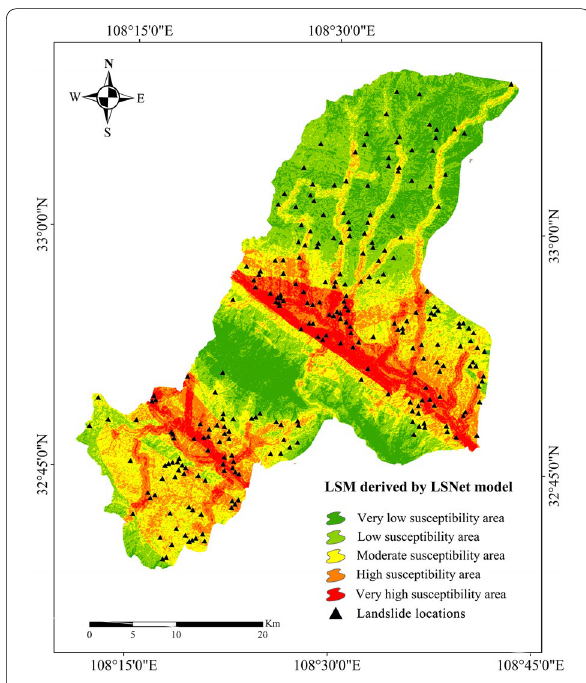
Fig. 8 The ROC curves of each landslide susceptibility model based on validation